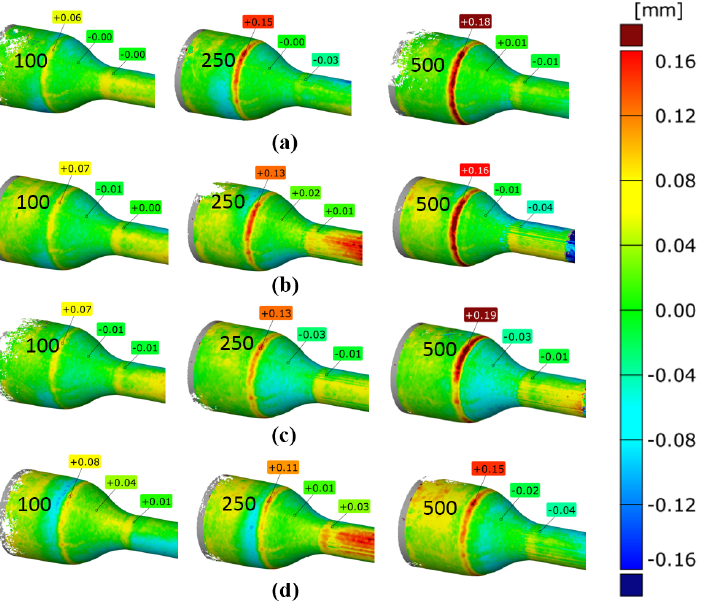
Figure 11. Three-dimensional (3D) scanning results of the next 100, 250, and 500 pieces of forgings: ( a ) variant 1; ( b ) variant 2; ( c ) variant 3; ( d ) variant 4. ( a ) variant 1; ( b ) variant 2; ( c ) variant 3; ( d ) variant